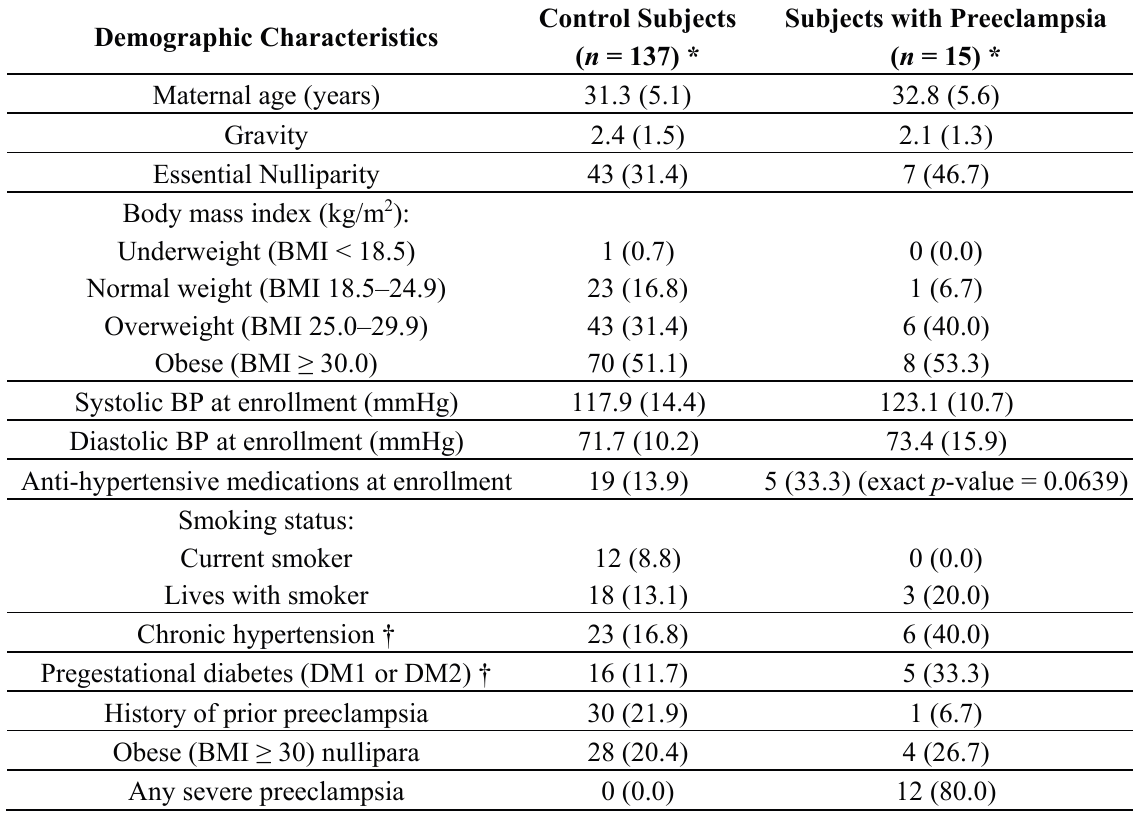
Table 1. Demographic Characteristics of Study